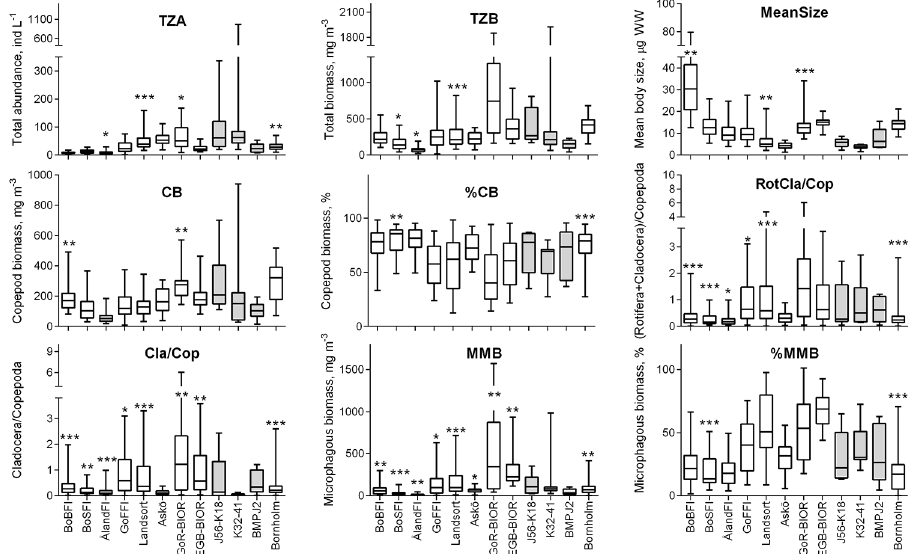
Fig 3. Variability of zooplankton indicators in the analyzed datasets. The datasets are indicated as Station . Box-and-whiskers show median, 25 and 75% percentiles, min and max values. Asterisks ( * : p < 0.05, ** : p < 0.01, and *** : p < 0.001) indicate significant deviations from Gaussian distribution using the Kolmogorov-Smirnov statistics applied to the data sets with (cid:4) 18 years of observations. Shaded columns indicate datasets that are < 12 years and thus not eligible for normality testing. See Tables 1 and 3 for the details on the indicators and